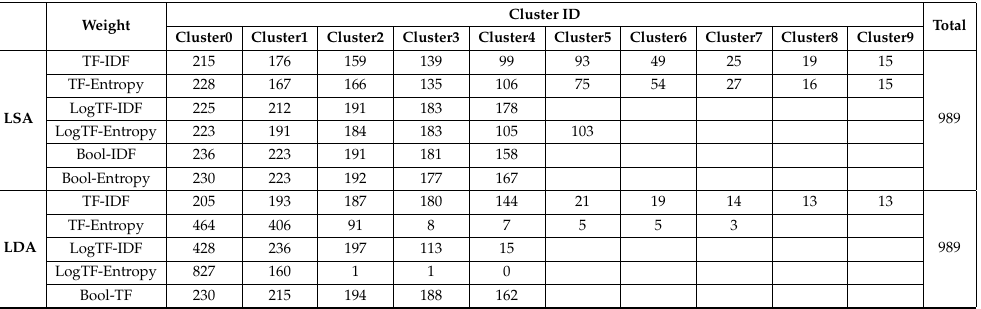
Table 11. Cardinality of each cluster set found for dataset D1 for the probabilistic